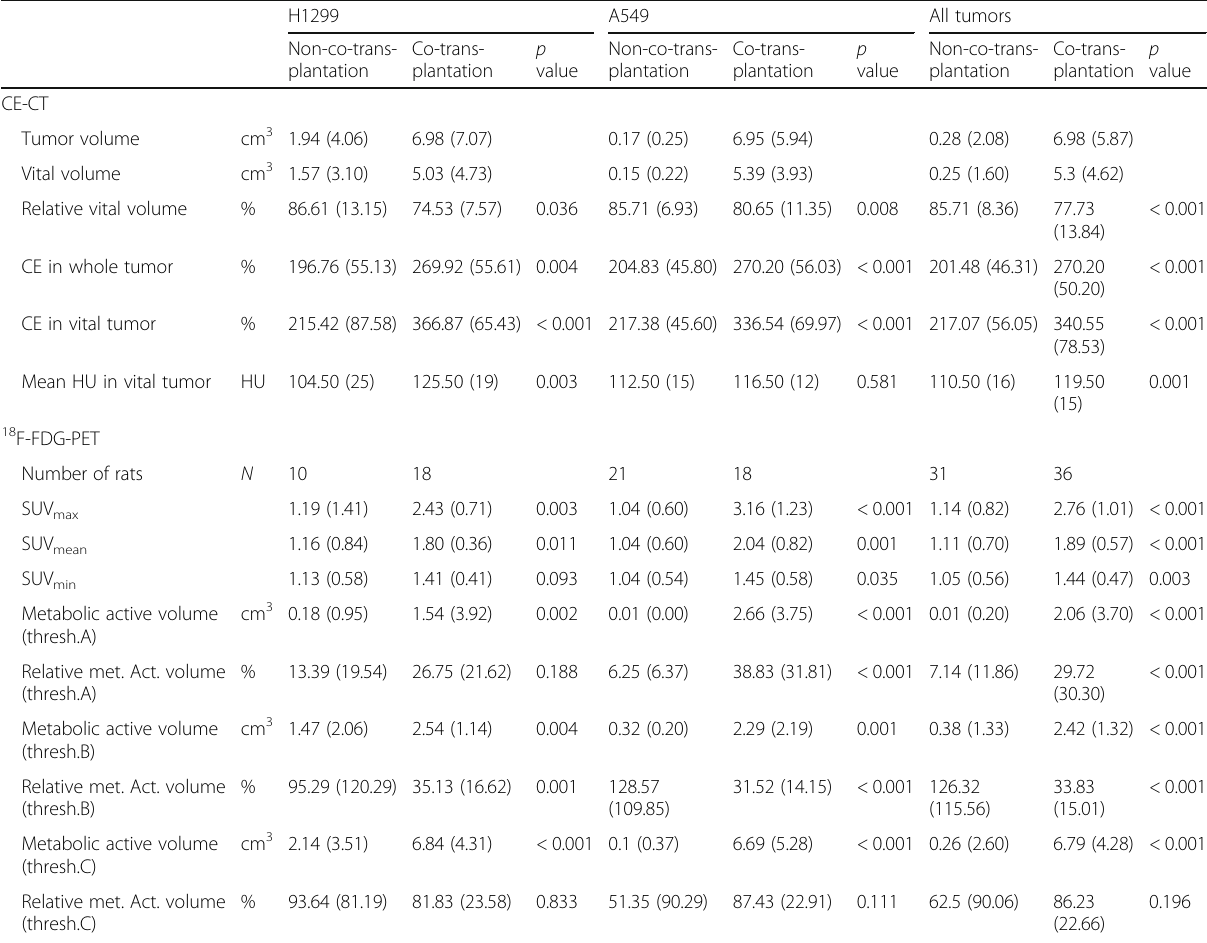
Table 2 Study results [18F]FDG-PET and CE-CT